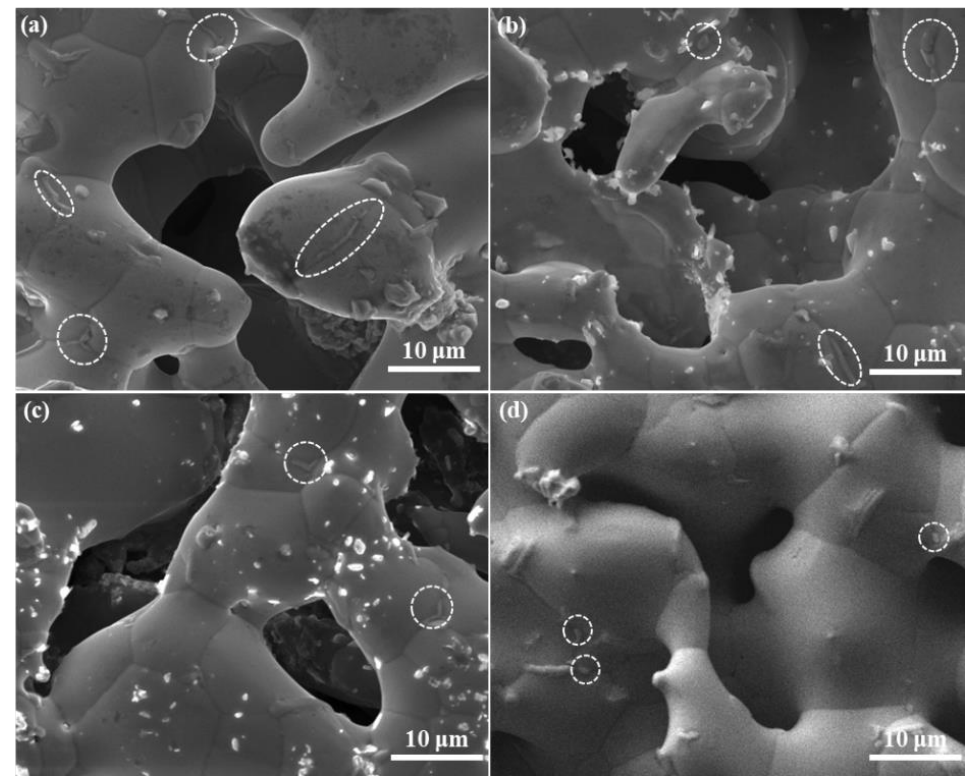
Figure 8. ( a ) SEM images of porous Fe20Cr5Al ( a ), Fe10Cr10Al ( b ), Fe10Cr20Al ( c ) and porous Fe20Cr5Al modified with 0.4wt.% B ( d ) after aging for 100 h,